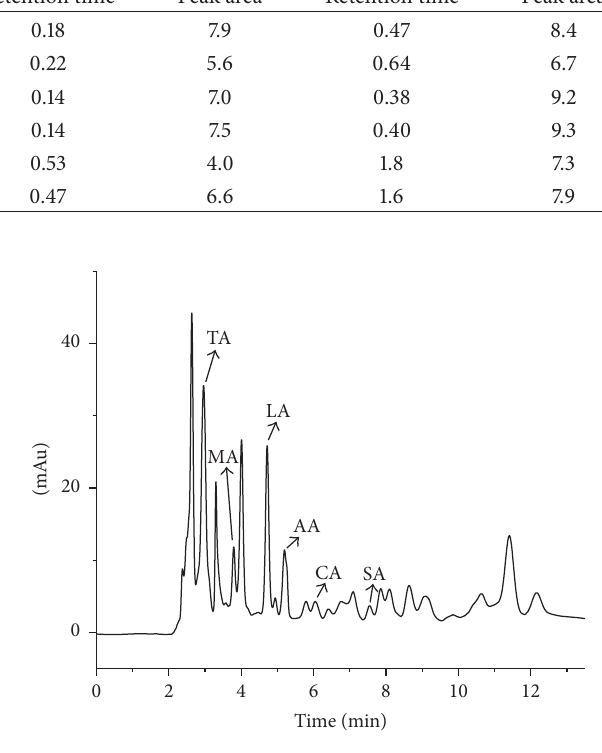
Figure 1: A typical chromatogram of sample